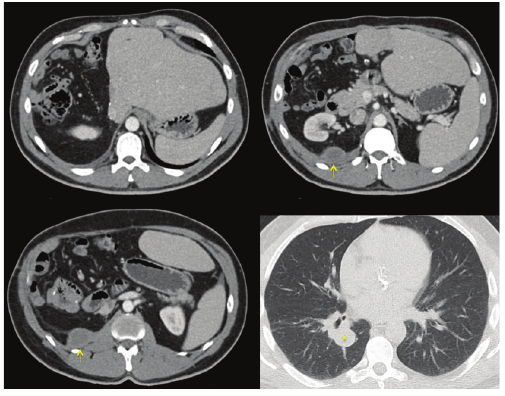
Figure 4: Abdomen and pelvis CT that shows a new retrocrural mass (arrows) and lower right pulmonary nodule (star). A previous right hepatectomy can be observed.